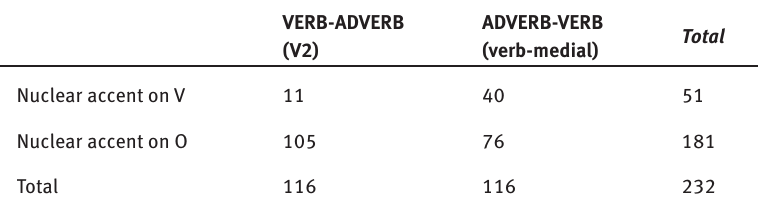
Table 5. The distribution of perceptually identified nuclear accents in the V2 and verb-medial sentences